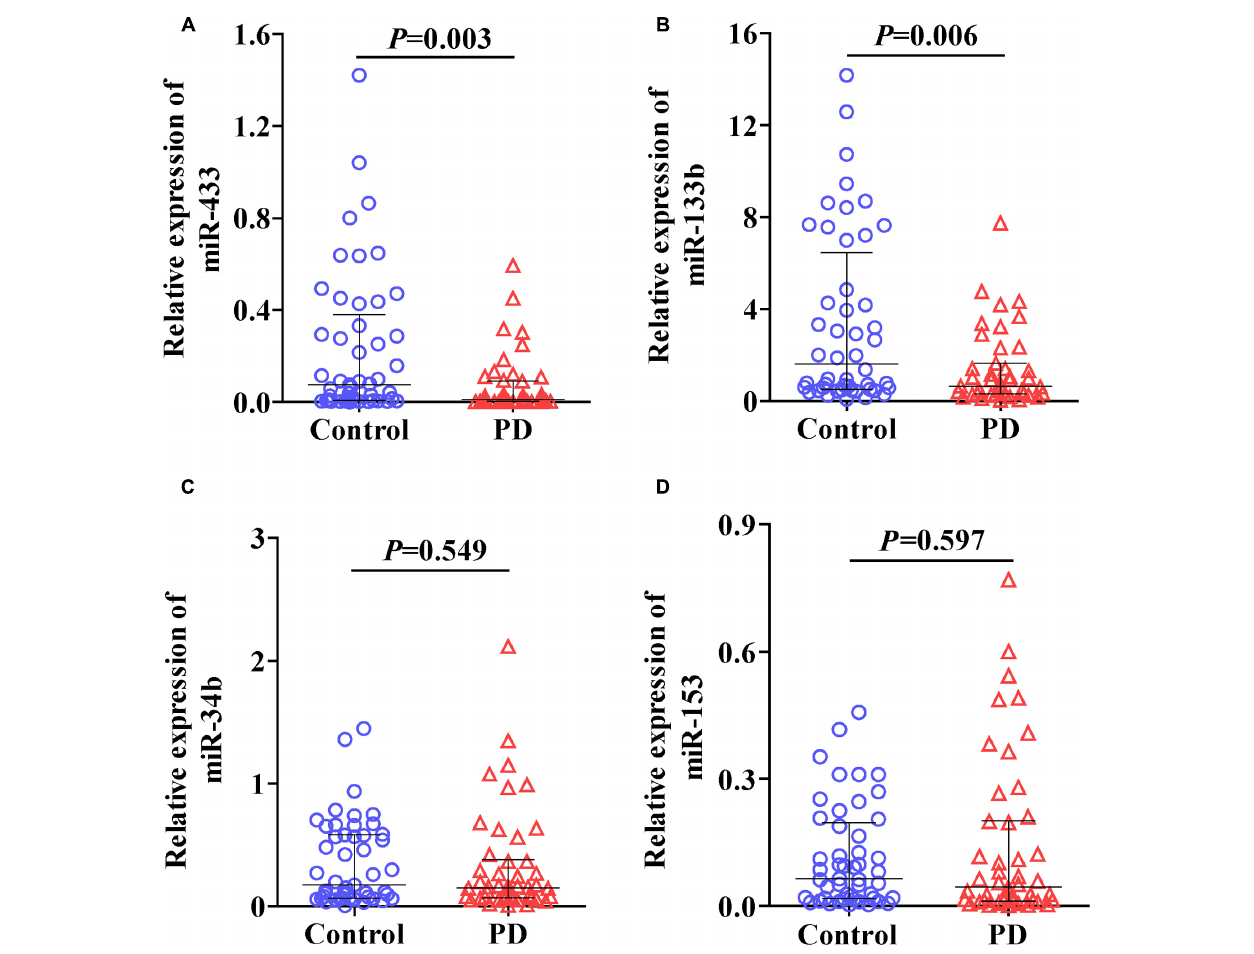
FIGURE 1 | Levels of miR-433 (A) , miR-133b (B) , miR-34b (C) , and miR-153 (D) in plasma of Parkinson’s disease (PD) patients and controls. Expression of miRNAs was expressed relative to their respective level of U6. The bar represents median with interquartile